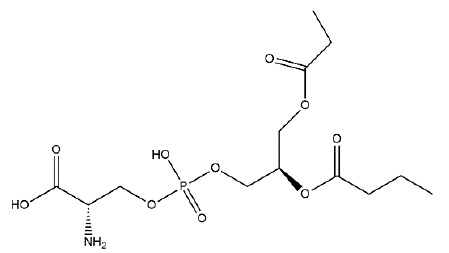
Figure 13. Schematic representation of the chemical structure of phosphatidylserine (PS). Exposure of PS on the surface of the vascular endothelium in cancer cells (lung, breast, pancreatic, bladder, skin, brain metastasis, etc.) is caused by oxidative stress [284]. In